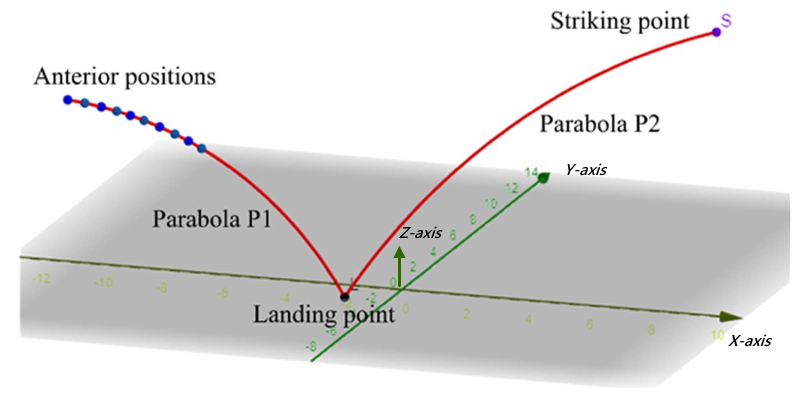
Figure 10. Diagram of trajectory